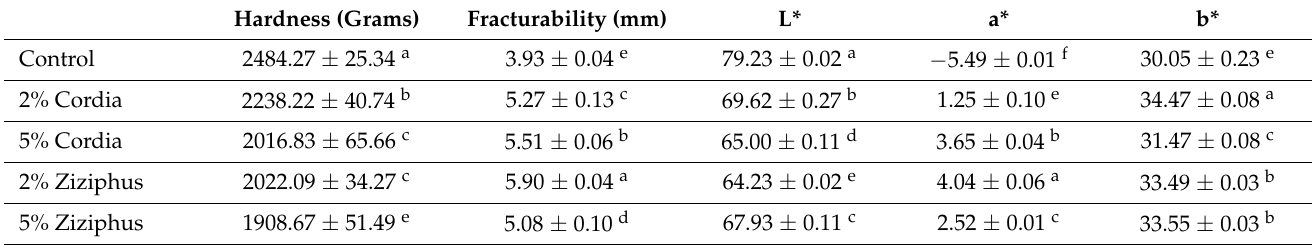
Table 4. Color, hardness and fracturability parameters of the cookies.